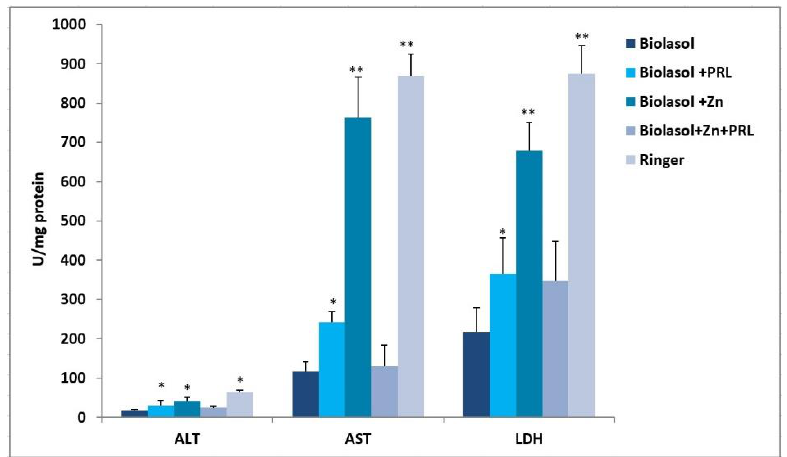
Figure 6. Activity of biochemical markers in the kidney homogenates in model of storing isolated porcine kidneys. The values are expressed as mean ± SEM. Data were analysed by one-way ANOVA and Bonferroni post hoc tests; n = 10; * p < 0.05; ** p < 0.01 compared to the control group (Biolasol).